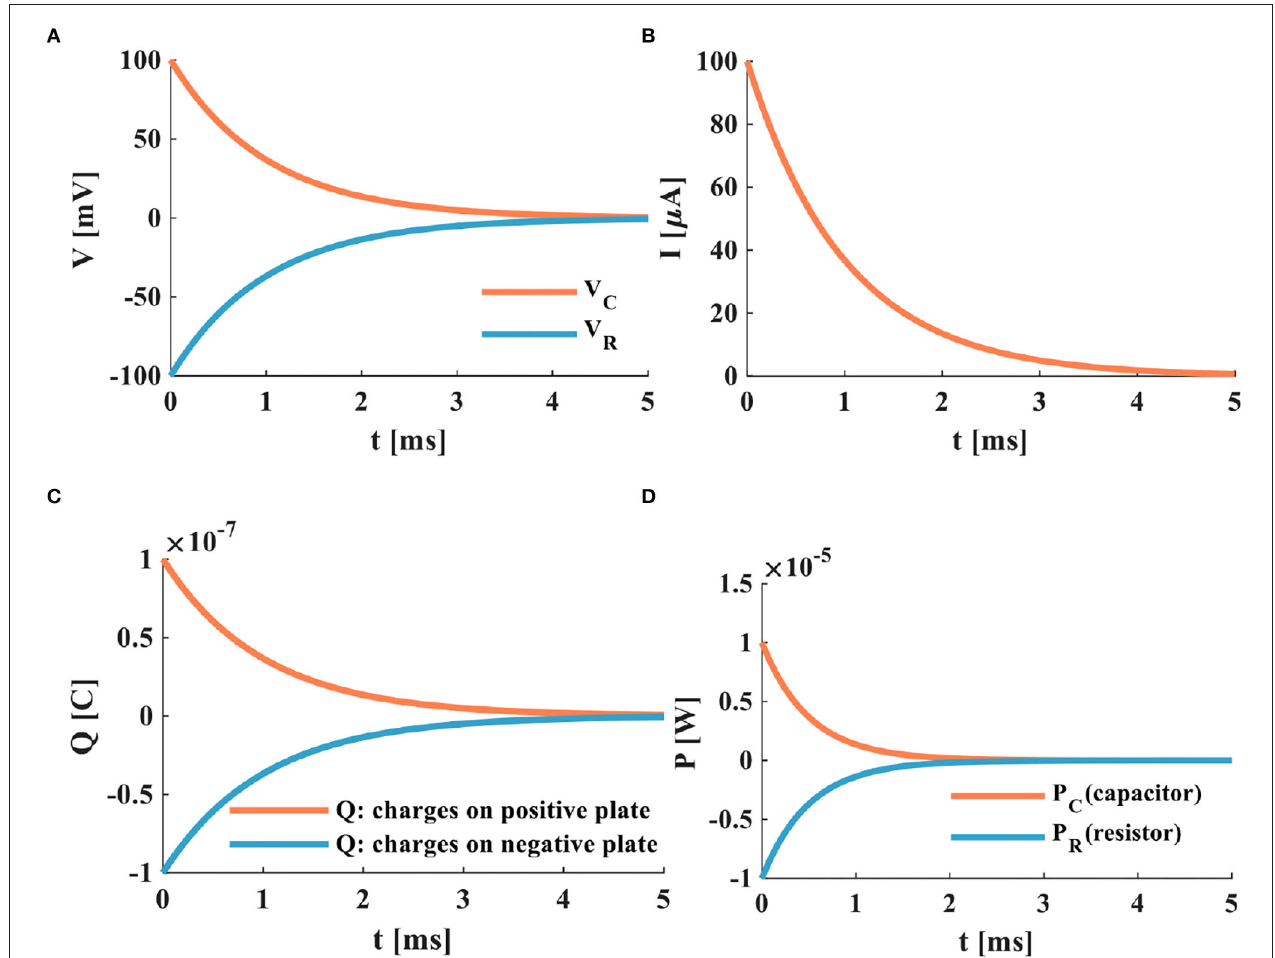
FIGURE 5 | The discharging process of the RC neuron circuit, (A) the membrane capacitor discharging process, (B) the discharging current of the RC neuron circuit, (C) the charges on positive and negative plates of the membrane capacitor, (D) the power variation of the RC neuron